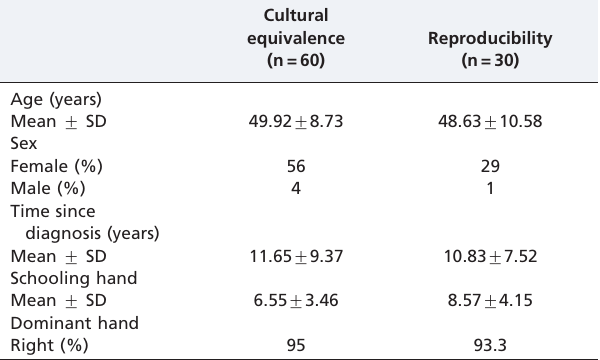
Table 1 - Demographic data of the patients (n =